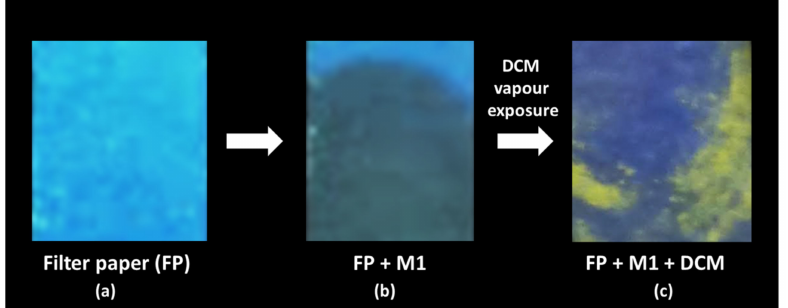
Figure 3. Images of filter paper (FP) under UV-visible lamp (365 nm): ( a ) filter paper (FP) only; ( b ) filter paper (impregnated with a solution of M1 in toluene) without DCM vapor; and ( c ) filter paper (impregnated with M1) in the presence of DCM vapors (turn on emission can be observed in the presence of DCM